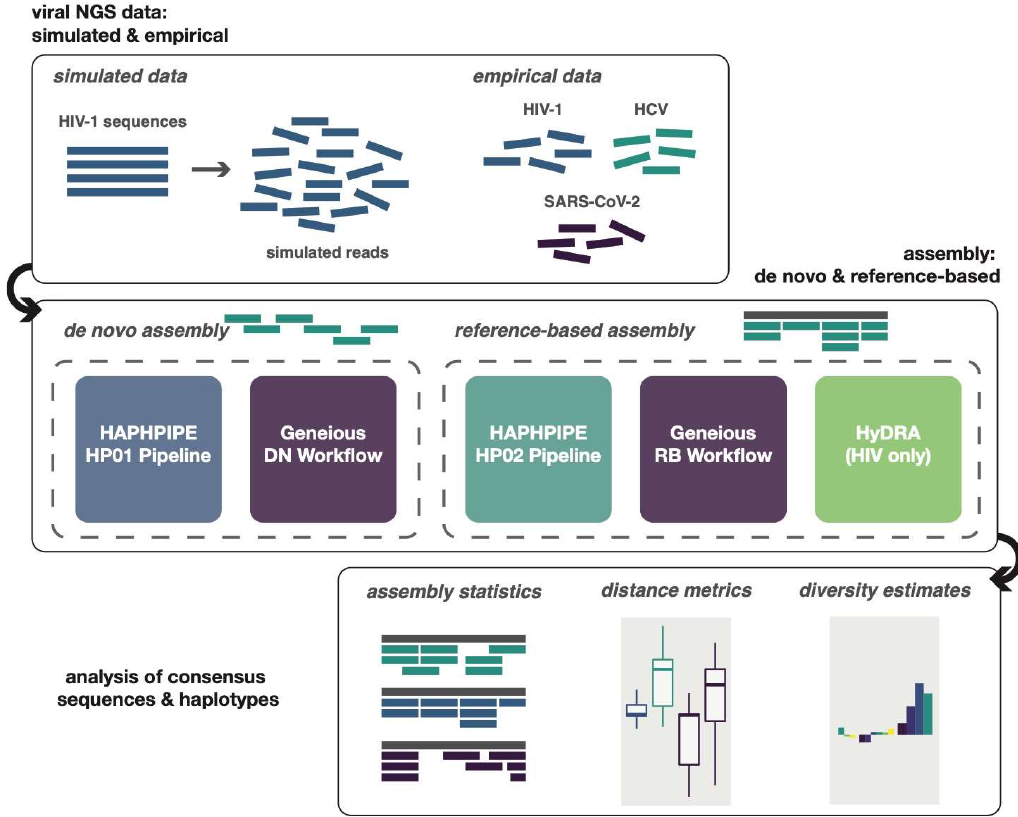
Figure 1. Methods overview. Sequencing reads were simulated for each simulation sample, while reads for empirical data were gathered from NCBI SRA database. Reads for each sample were assembled and a consensus sequence generated through the de novo pipelines for HAPHPIPE (HP01) and Geneious and the reference-based pipelines for HAPHPIPE (HP02), Geneious, and HyDRA. Only HIV samples were analyzed through HyDRA, because HyDRA is HIV-specific. All resulting consensus sequences were analyzed using a variety of metrics including assembly statistics, genetic distance from reference or true sequence metrics, and diversity estimates, such as nucleotide